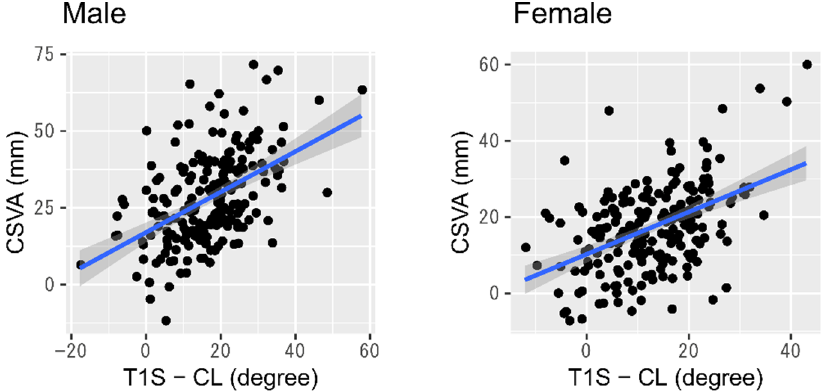
Figure 2. Relationship between cervical anteriorization and T1S minus CL. Abbreviations: CSVA, cervical sagittal vertical axis; T1S, T1 slope; CL, cervical lordosis.